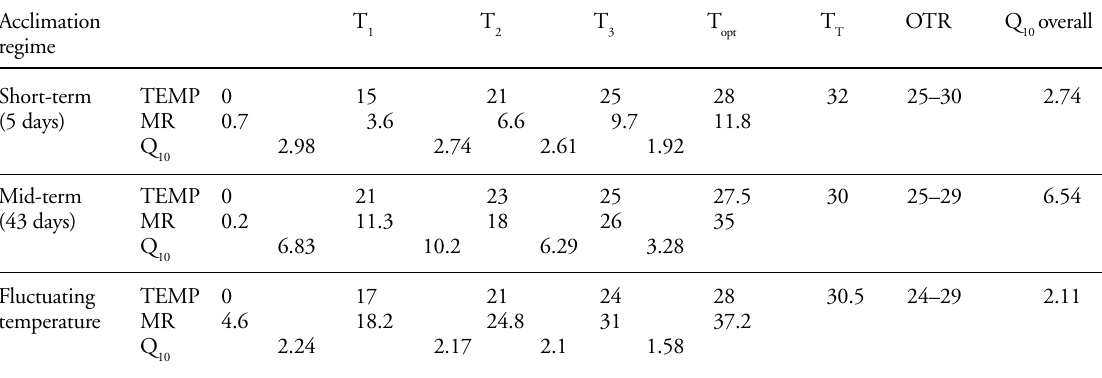
(0 o C to T 10 opt